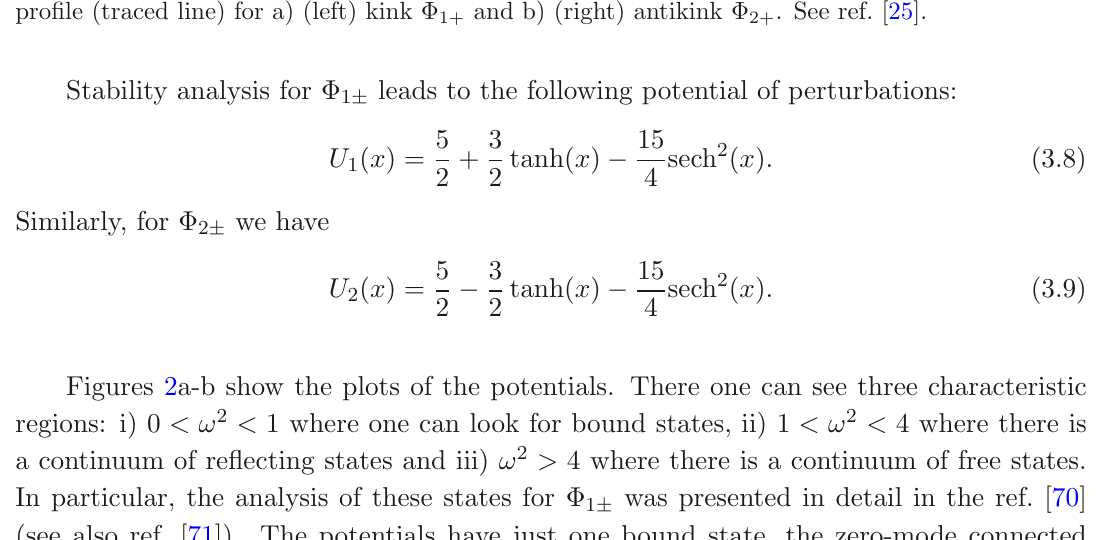
Figure 2 . The φ 6 model on the full line: Schr¨odinger-like potential (solid line) and scalar field profile (traced line) for a) (left) kink Φ 1+ and b) (right) antikink Φ 2+ . See ref.